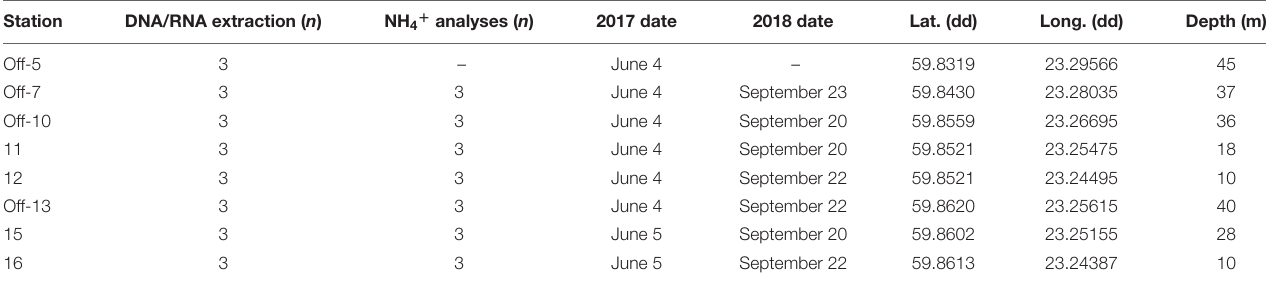
TABLE 1 | List of the station numbers (“off” denotes offshore stations (5, 7, 10, 13), and inshore stations are denoted solely by their station number 11, 12, 15, 16), the number of sediment cores collected and sliced (0–2 cm surface) for DNA/RNA extraction or pore water NH 4 + analyses, sampling dates during June 2017 and September 2018, latitude, longitude, and water column depth. Station DNA/RNA extraction ( n